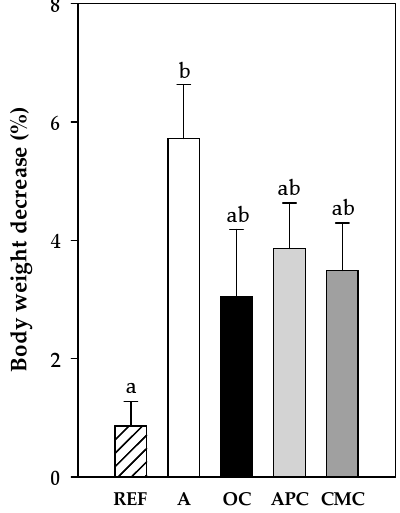
Figure 5. Body weight decrease (%) 24 h after the intranasal challenge with respect to the body weight before the challenge. REF: healthy reference group fed standard diet; A: asthmatic group fed standard diet; OC: asthmatic animals fed with ordinary cocoa-enriched diet; APC: asthmatic animals fed with “Amazonas Peru” cocoa-enriched diet; CMC: asthmatic animals fed with “Criollo de Montaña” cocoa-enriched diet. Results are represented as mean ± standard error of the mean ( N = 9). Values not sharing letters denote significant di ff erences between groups ( p < 0.01), while values sharing the same letter did not di ff